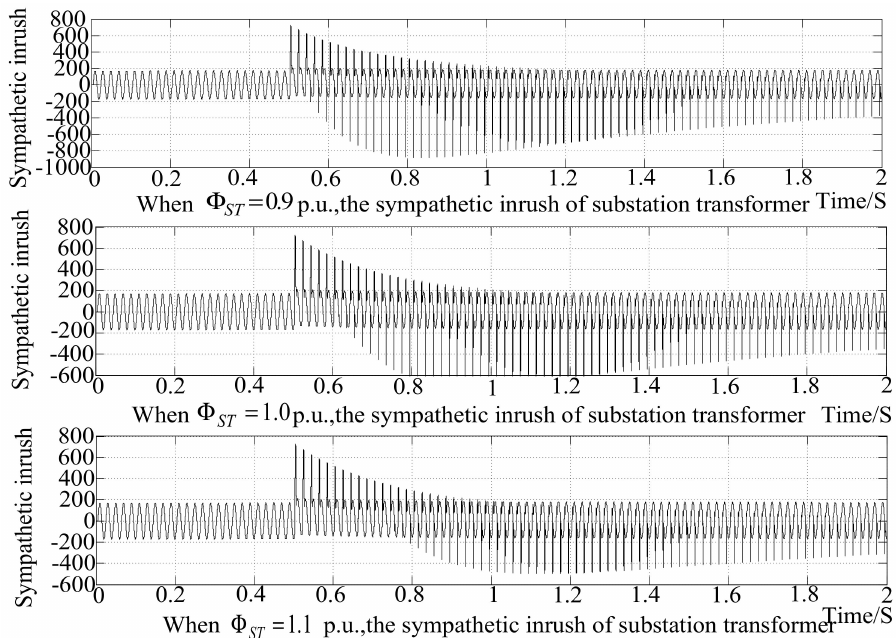
Figure 13. Influence of traction transformer capacity on sympathetic